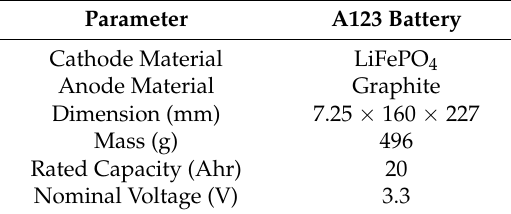
Table 1. LFP pouch cell specifications.